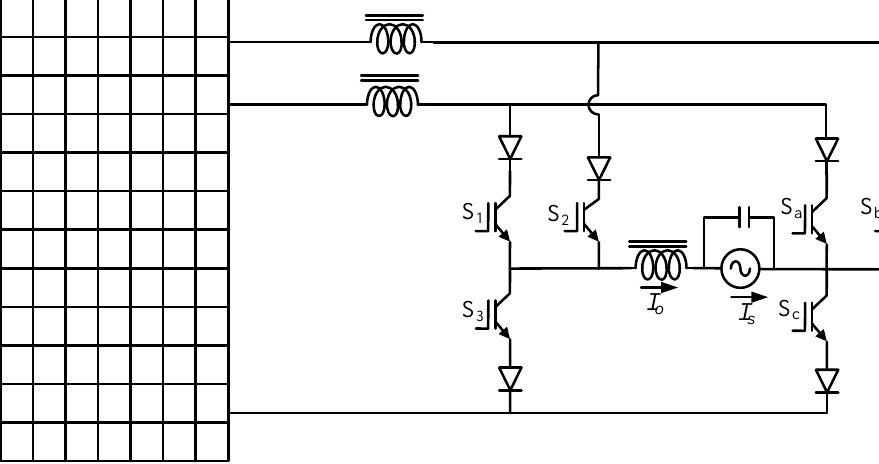
Figure 10. A multilevel CSI topology. Table 1. Traditional two-level inverters Vs MLI.